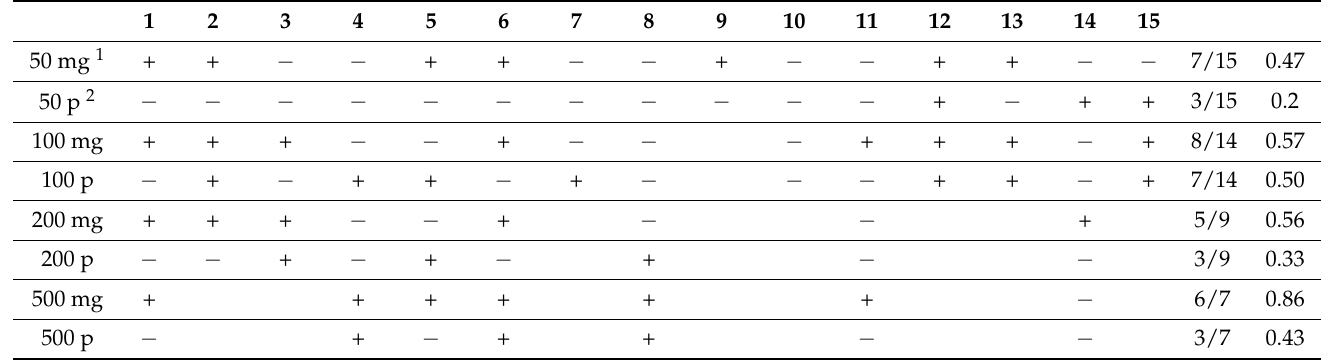
Table 2. Gluten immunogenic peptide (GIP) excretion in urine samples.